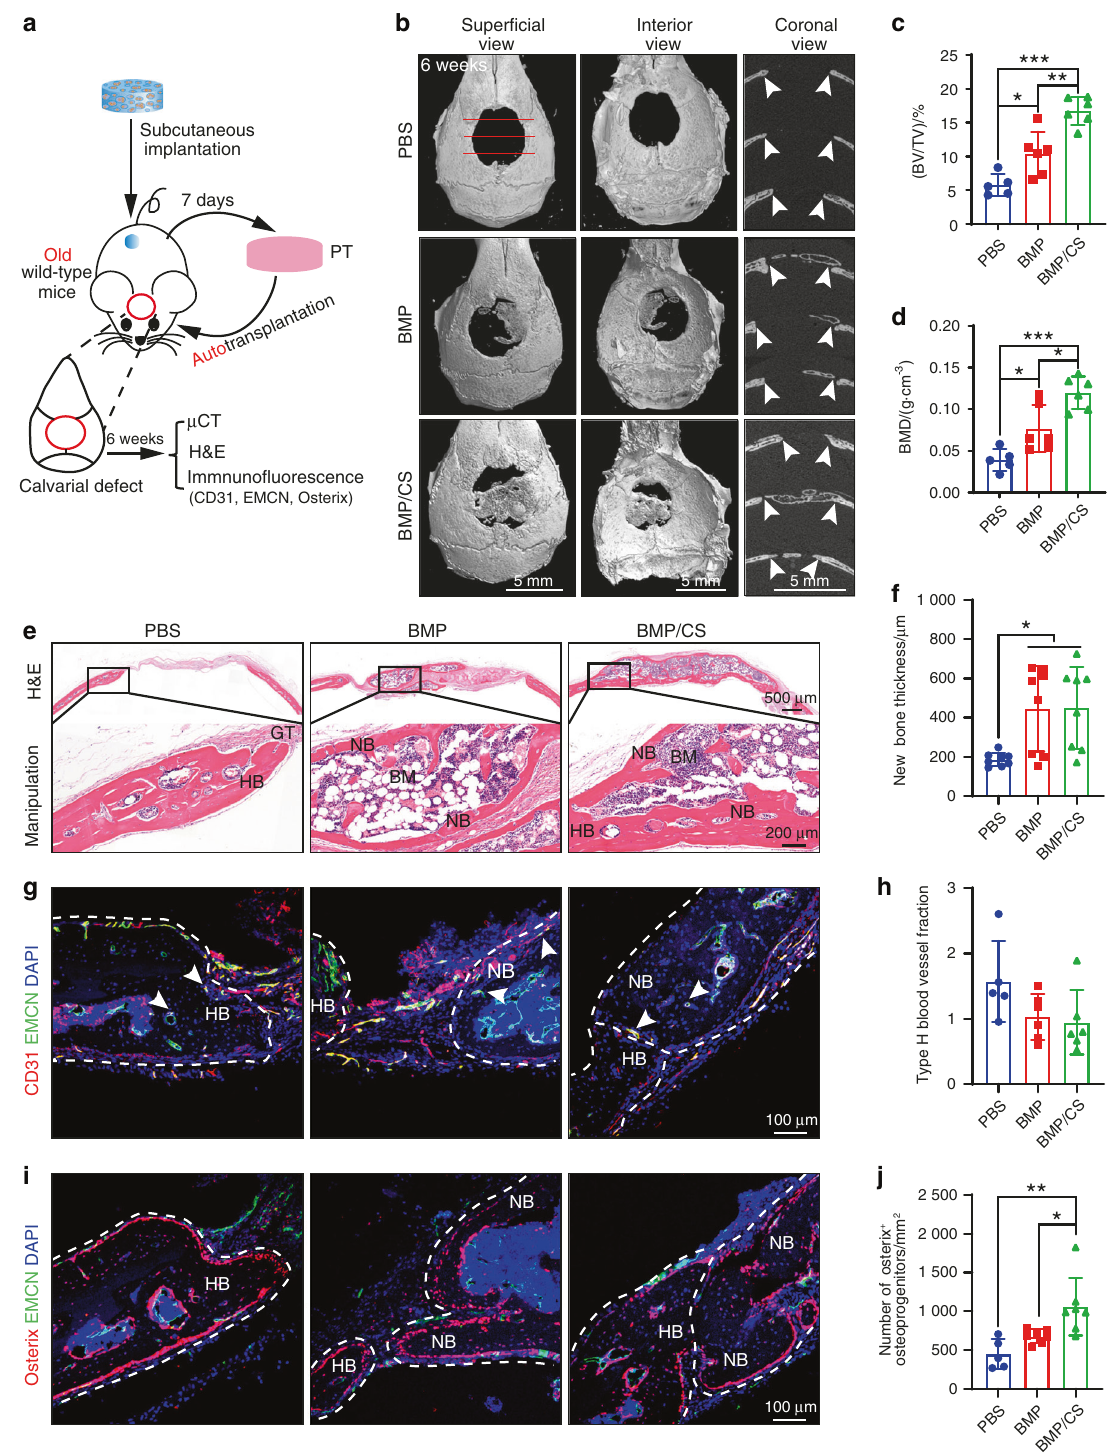
Fig. 7 Induced PTs accelerate calvarial reconstruction via autologous transplantation in old mice. a Scheme of autologous transplantation in old wild-type mice. b Super fi cial, interior and coronal views of the calvaria at week 6 after surgery ( n = 5 – 6). Images were taken at week 6 for animals transplanted with PBS-, BMP-, or BMP/CS-induced autologous PTs. The white arrowhead indicates the integration site. Scale bar, 5 mm. c , d Quantitative analysis of BV/TV ( c ) and BMD ( d ). e , f H&E staining ( e ) and quantitative analysis ( f ) were used to assess the integration of transplanted PT with host bone (HB) ( n = 8). g – j Immuno fl uorescence staining and quantitative analysis of type H blood vessels (EMCN + CD31 + , yellow; g , h ) and Osterix + osteoprogenitors (red; i , j ) in the PBS, BMP, and BMP/CS groups at week 6 after allogenic transplantation in old mice ( n = 5 – 7). Bone marrow BM, new bone NB, host bone HB, granulation tissue GT. EMCN-positive cells are green, CD31- and Osterix- positive cells are red, and DAPI is blue (nucleus). The white arrowhead indicates type H blood vessels ( g ). The white dashed line indicates the host bone or new bone area ( g , i ). Scale bar (top: low magni fi cation, 500 μ m; bottom: high magni fi cation, 200 μ m; d ) and 100 μ m ( f , h ). Data are presented as the mean ± SD. * P < 0.05, ** P < 0.01, *** P < 0.001, one-way ANOVA followed by Tukey ’ s post hoc